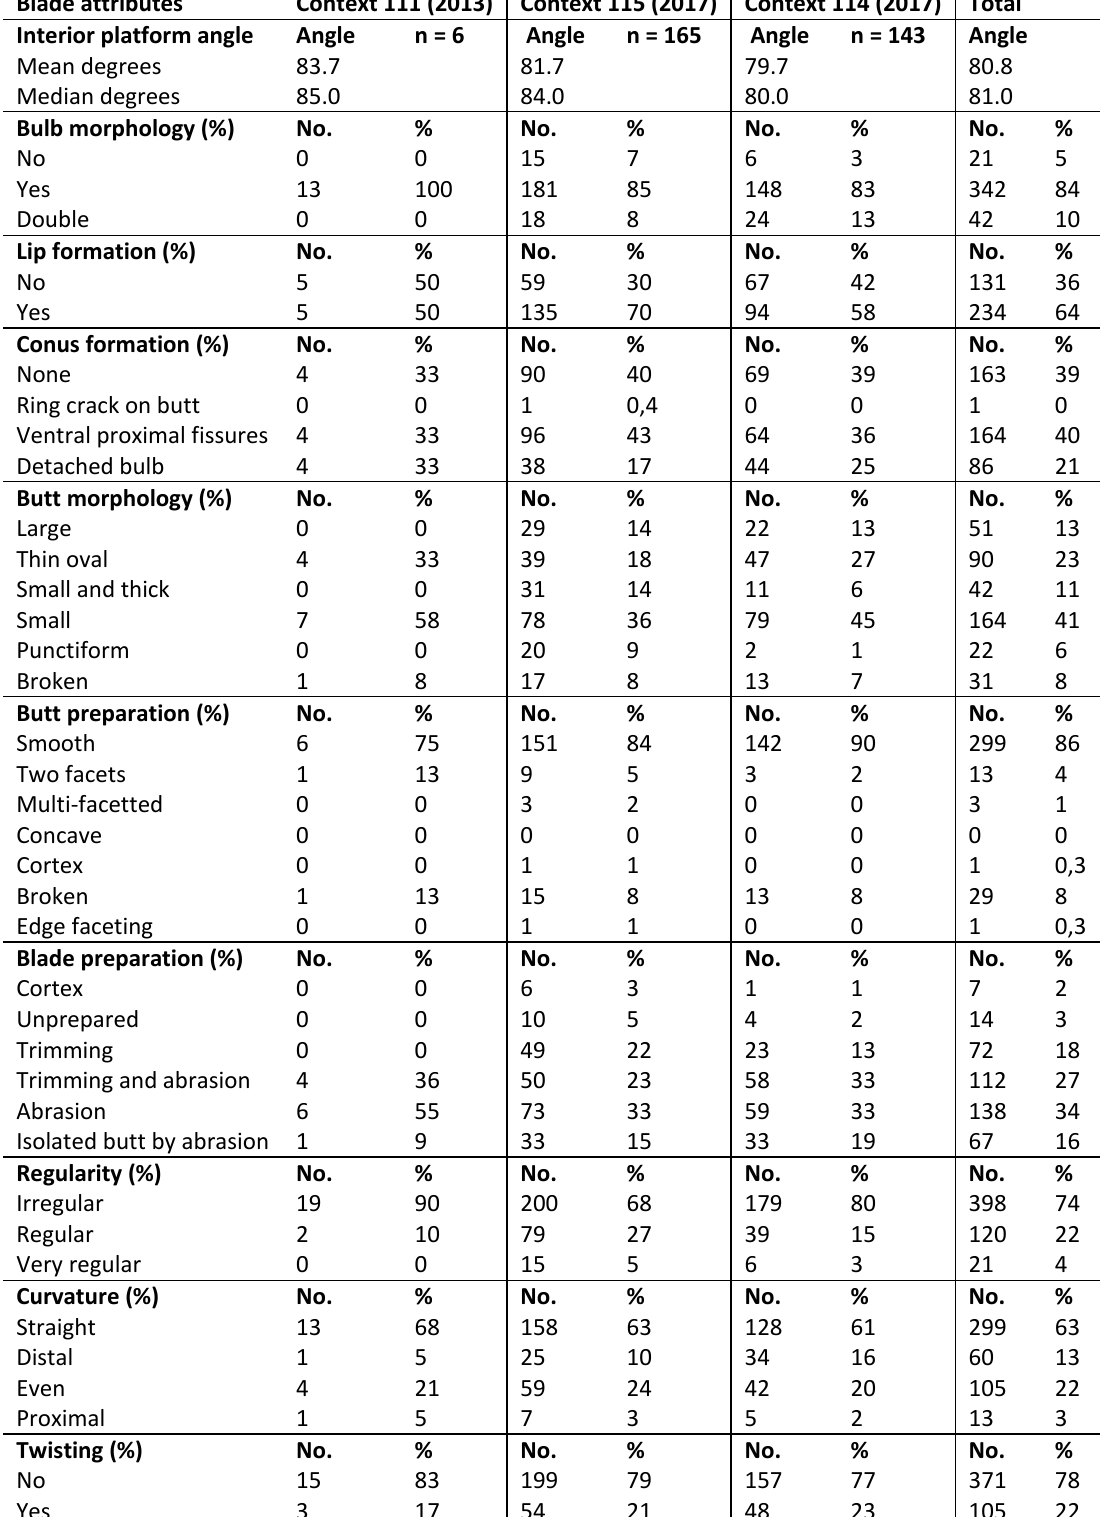
Table 2. Descriptive statistics of essential blade attributes from RPAS Context (111) and Contexts (115) and (114) from 2017 excavation. The sample comprises complete blades and blade fragments